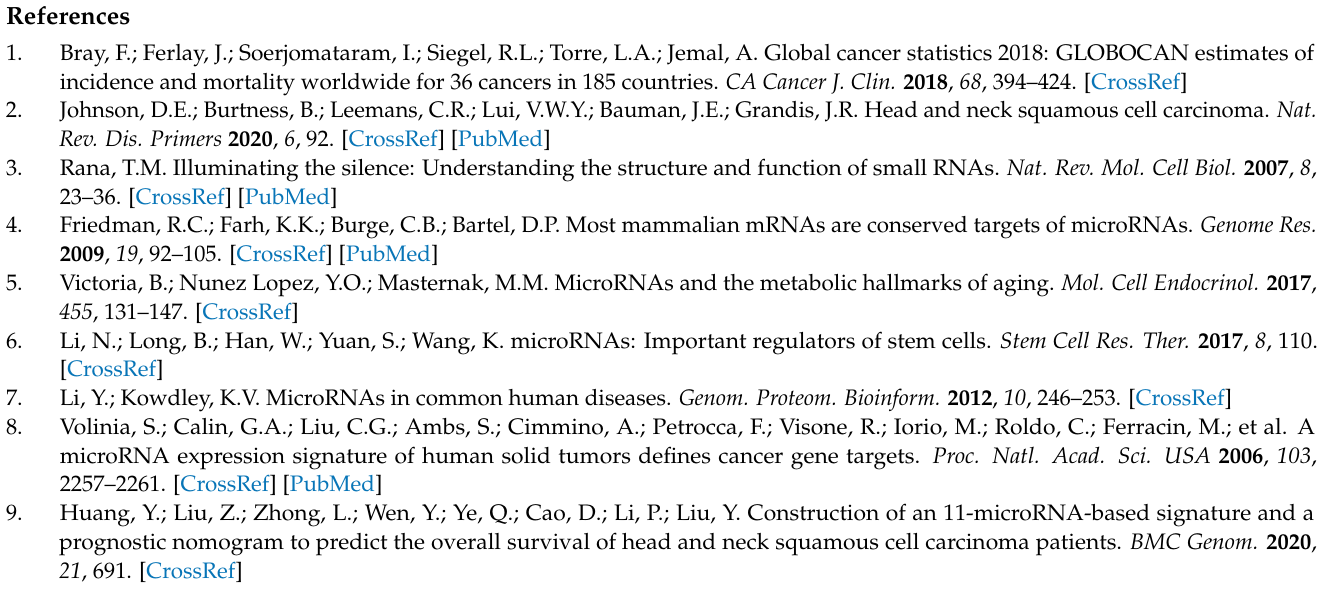
Figure S6: Kaplan Meier survival curves showing comparison of overall survival between low